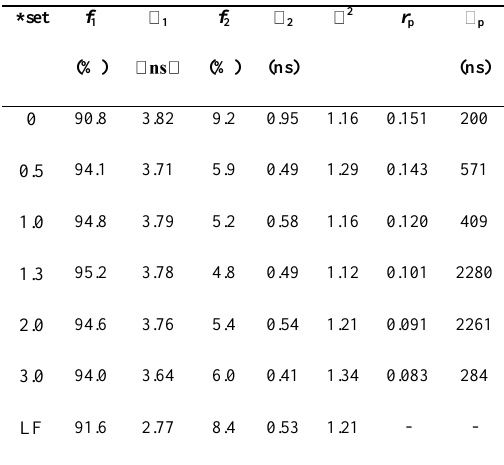
The anisotropy r p and the correlation time p extracted from the plateau region of the anisotropy decay